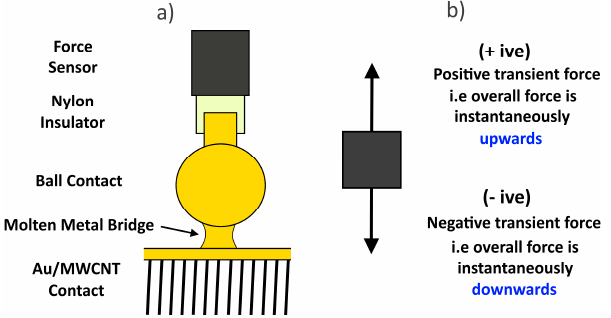
Figure 4. The contact force measurement arrangement ( a ) and a free body diagram of the force sensor showing the convention used in graphs for positive and negative force ( b ). Technologies 2019 , 7 , x FOR PEER REVIEW